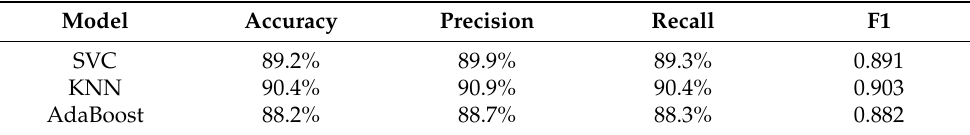
Table 19. Results for classification models when trained using body gesture and action attributes.